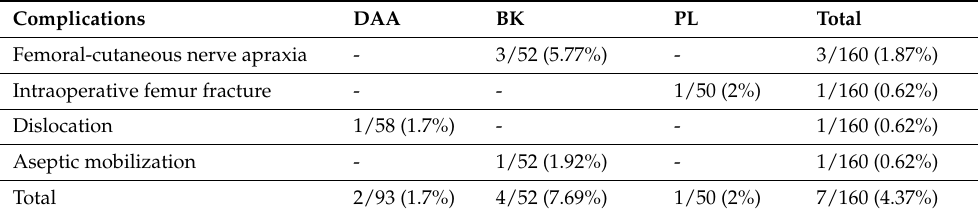
Table 2. Complications divided by approach and incision.